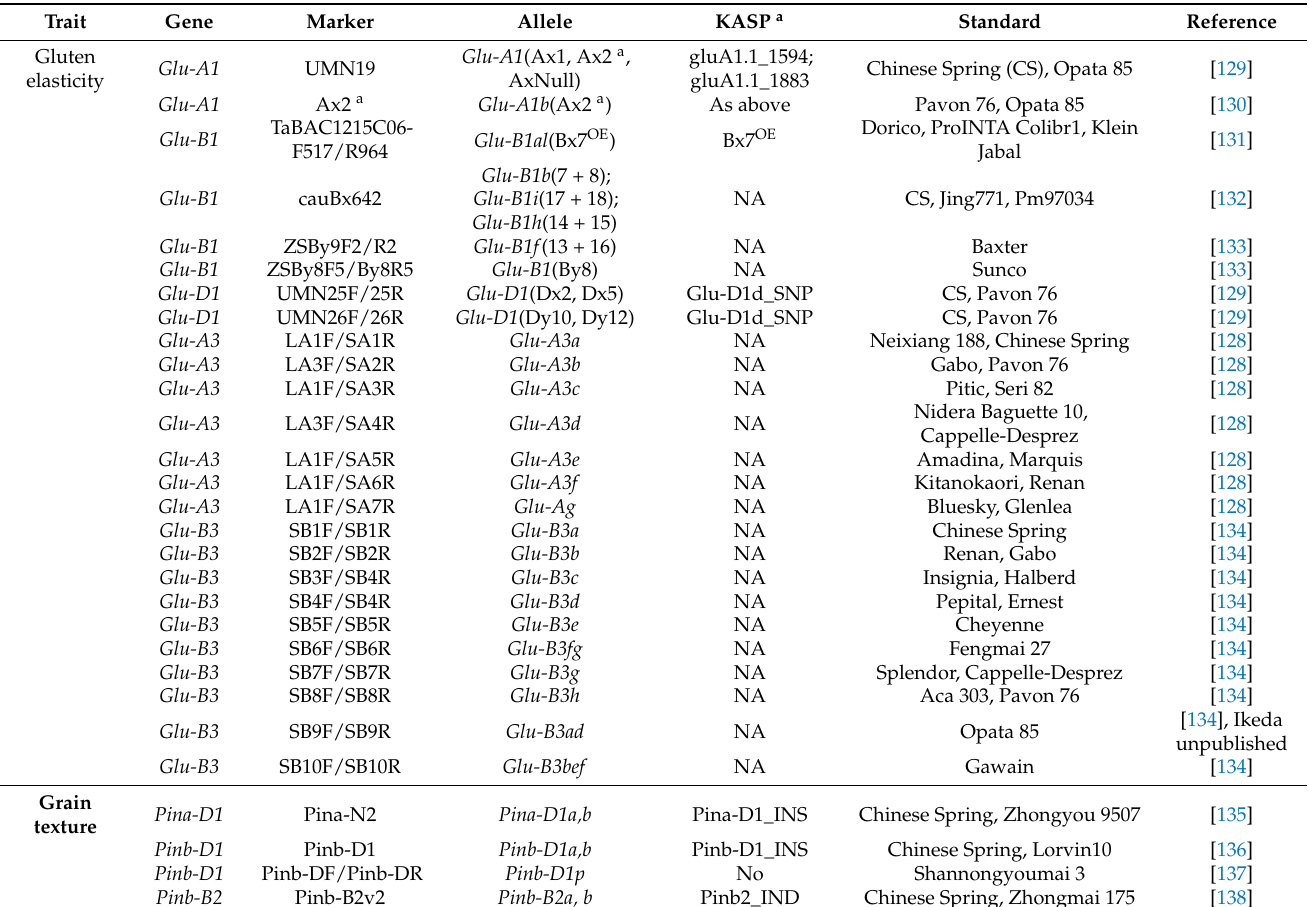
Table 2. List of all functional markers available in wheat along with their KASP counterpart and standard cultivars for allele